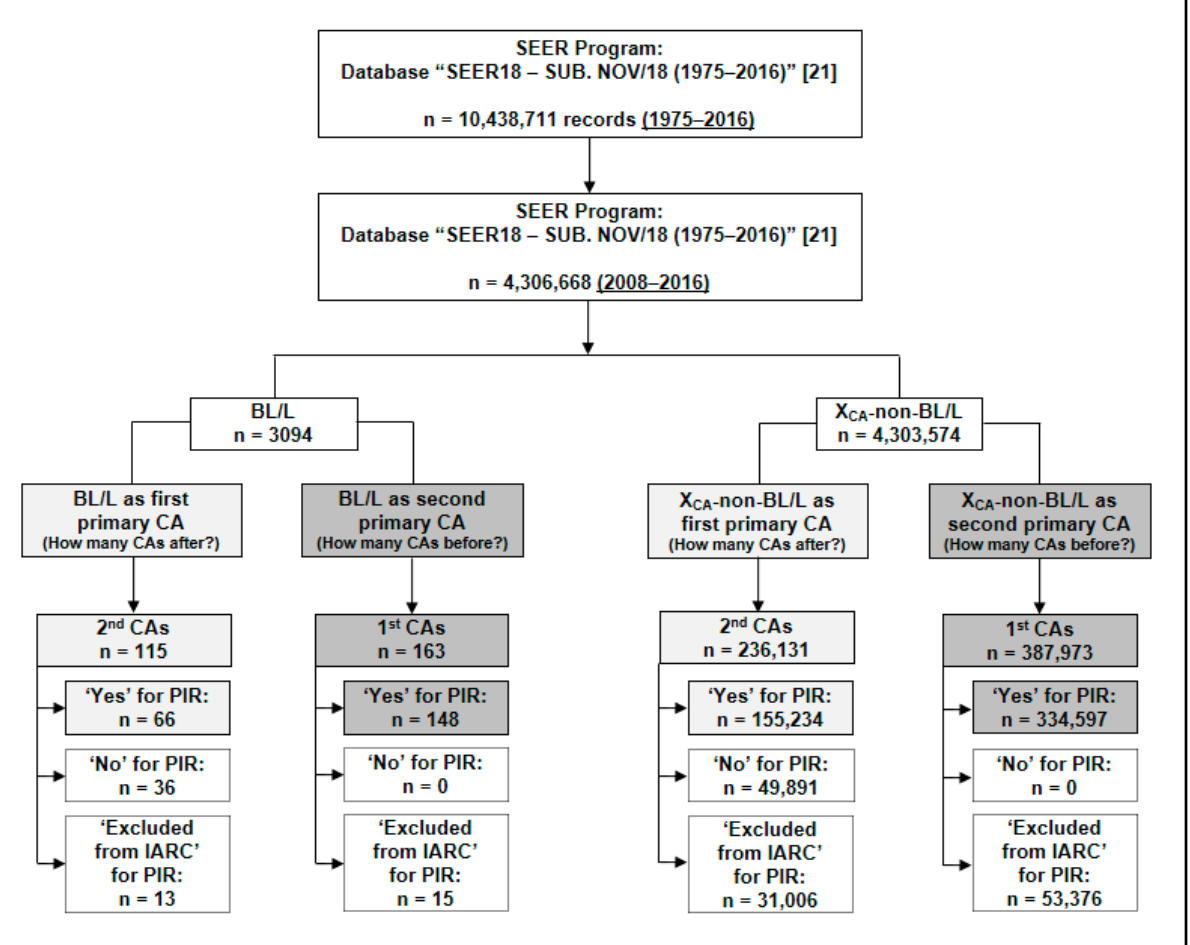
Figure 2. Data collection flowchart for the risk analysis of primary cancers before and after BL/L with BL/L behaving as an SPC and any cancer other than BL/L behaving as an SPC, respectively. Abbreviations: BL/L, Burkitt lymphoma/leukemia; CA, cancer; IARC, International Agency for Research on Cancer; PIR, primary cancer by international rules; SEER, Surveillance, Epidemiology and End Results; SPC, second primary cancer; X CA -non-BL/L, any cancer other than Burkitt lymphoma/leukemia.